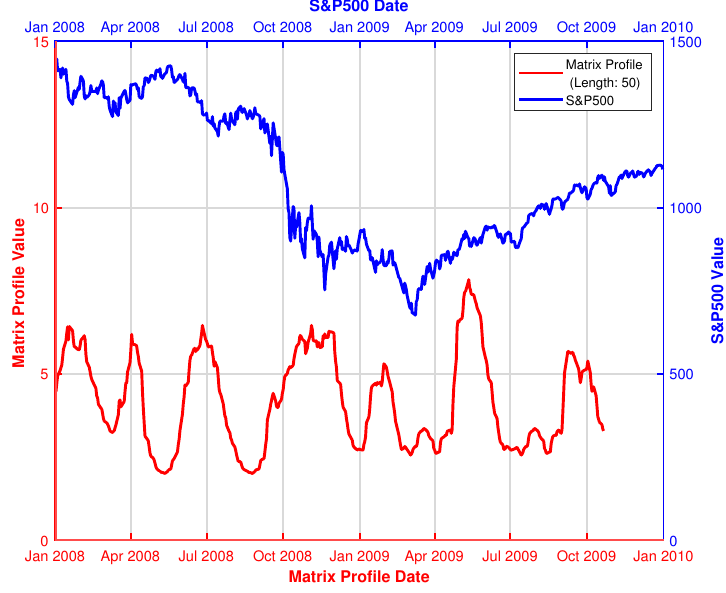
Figure 4. Sample matrix profile representation ( red series ) of the S&P500 ( blue ) series between January 2008 and January 2010. Here low MP values indicate a close match with another sub-sequence (of MP length) at some other point within the S&P500 . This point is given by the associated Matrix Profile Index ( MPI )